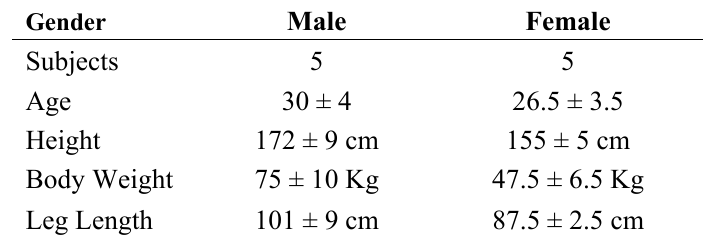
Table 1. The age, gender, height, weight, and leg length of the 10